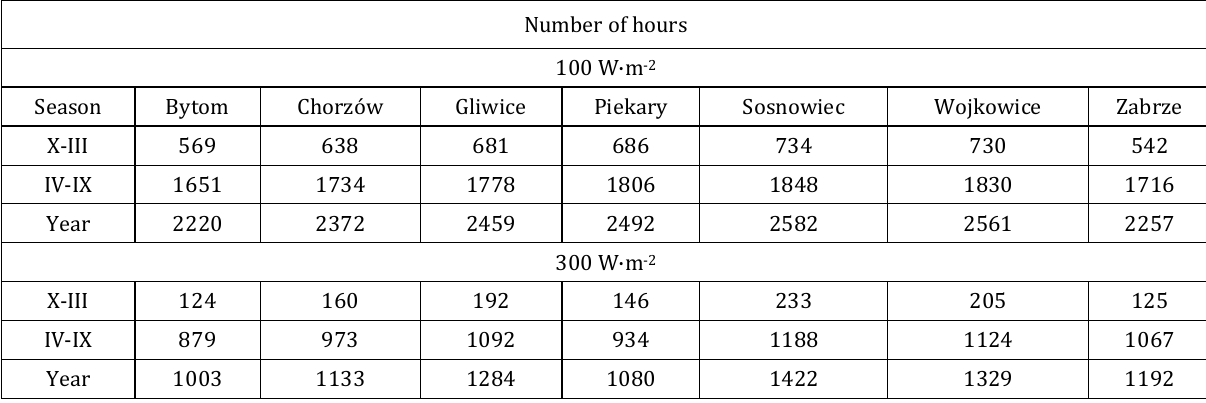
Table 2. Number of hours with global radiation exceeding the 100 W·m -2 and 300 W·m 2 threshold values in the period 1994–2004